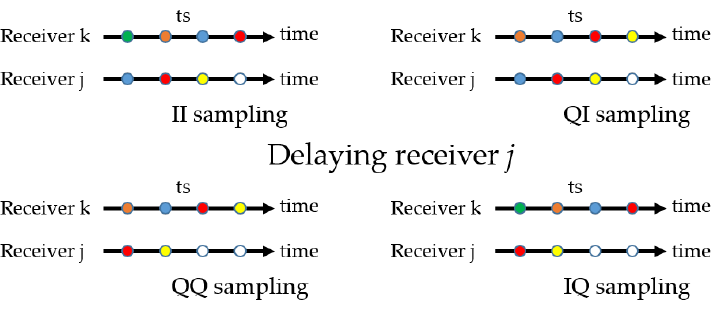
Figure 3. Sampling strategy for delaying receiver k two clock periods based on the non-delayed reference of Figure 2. Only the red snapshot is complete.